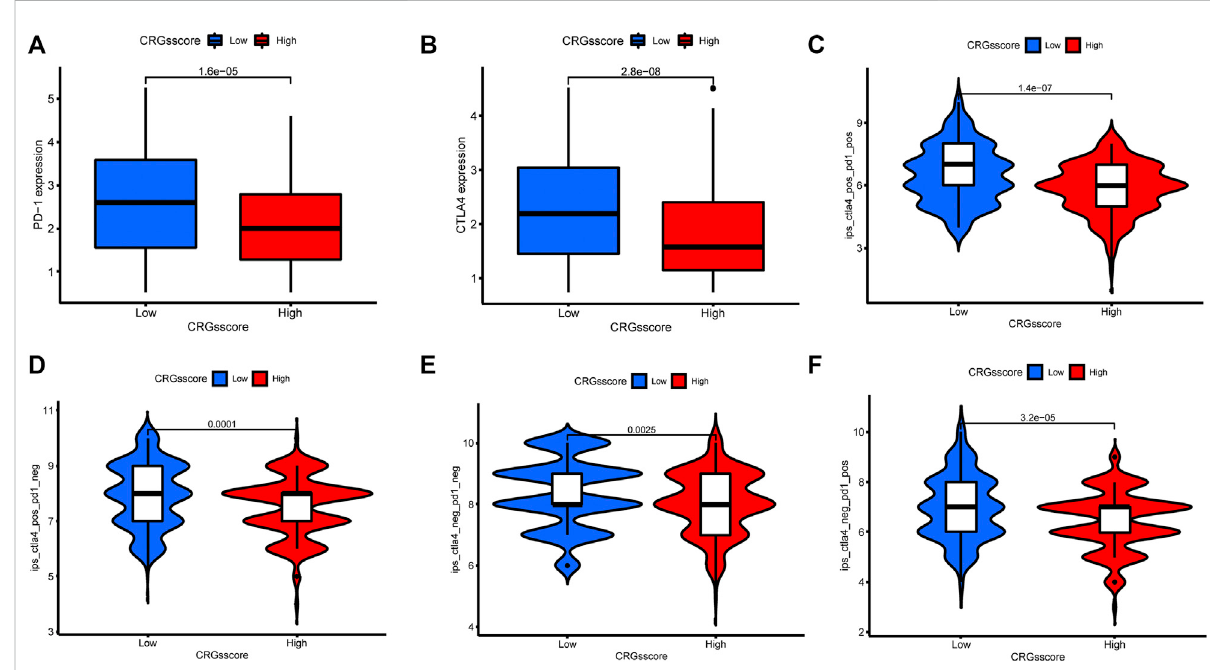
FIGURE 8 The association between CRGs score and immunotherapy. (A,B) The different expression of PD-1 and CTLA-4 in low CRGs score and high CRGs score. (C – F) Relationship between CRGs score and immunotherapeutic response of PD-1 and CTLA-4 expression: (C) positive PD-1 and CTLA-4. (D) Positive CTLA-4 and negative PD-1. (E) Negative PD-1 and CTLA-4. (F) Negative PD-1 and positive